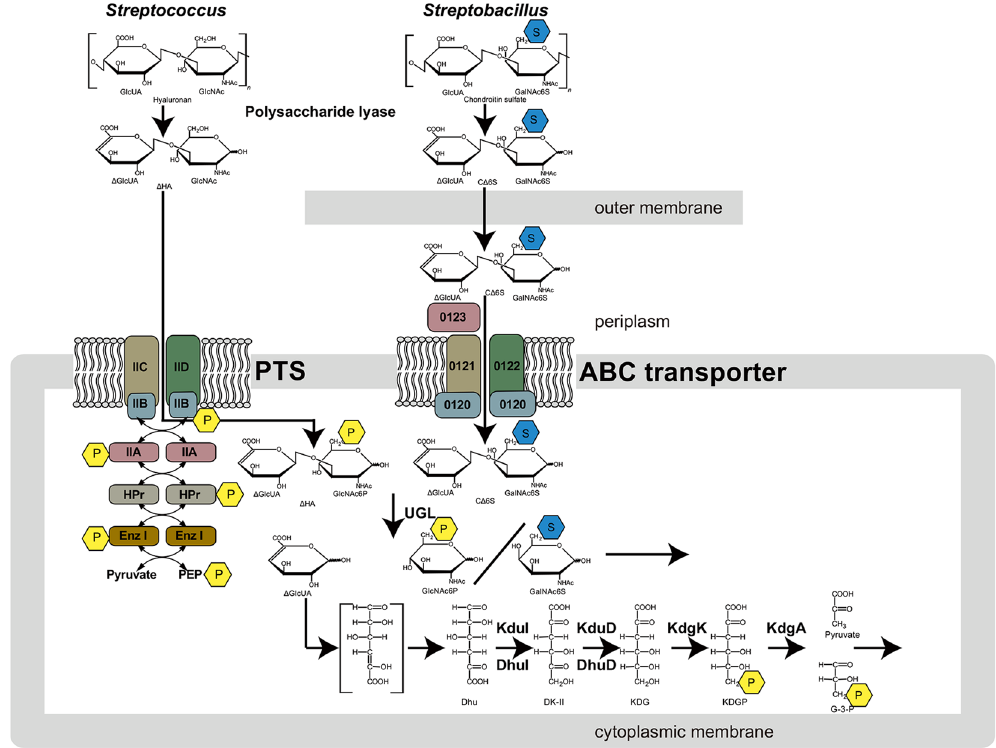
Figure 1. Bacterial system for degradation and import of GAGs. GAGs such as hyaluronan and chondroitin sulfate are depolymerized to unsaturated disaccharides by extracellular or cell-surface polysaccharide lyases. The resultant unsaturated disaccharides are incorporated to cytoplasm by PTS or periplasmic binding protein- dependent ABC transporter. In the case of PTS, substrates (unsaturated disaccharides) are phosphorylated across the cytoplasmic membrane. Unsaturated disaccharides are degraded to constituent monosaccharides (unsaturated uronate and amino sugar) by UGL, and the resultant unsaturated uronate is metabolized to pyruvate and glyceraldehyde-3-phosphate (G-3-P) by subsequent reactions of isomerase, reductase, kinase and aldolase. The pathway and proteins/enzymes are detailed in the text. P enclosed in a yellow hexagon, phosphate group; S enclosed in a cyan hexagon, sulfate